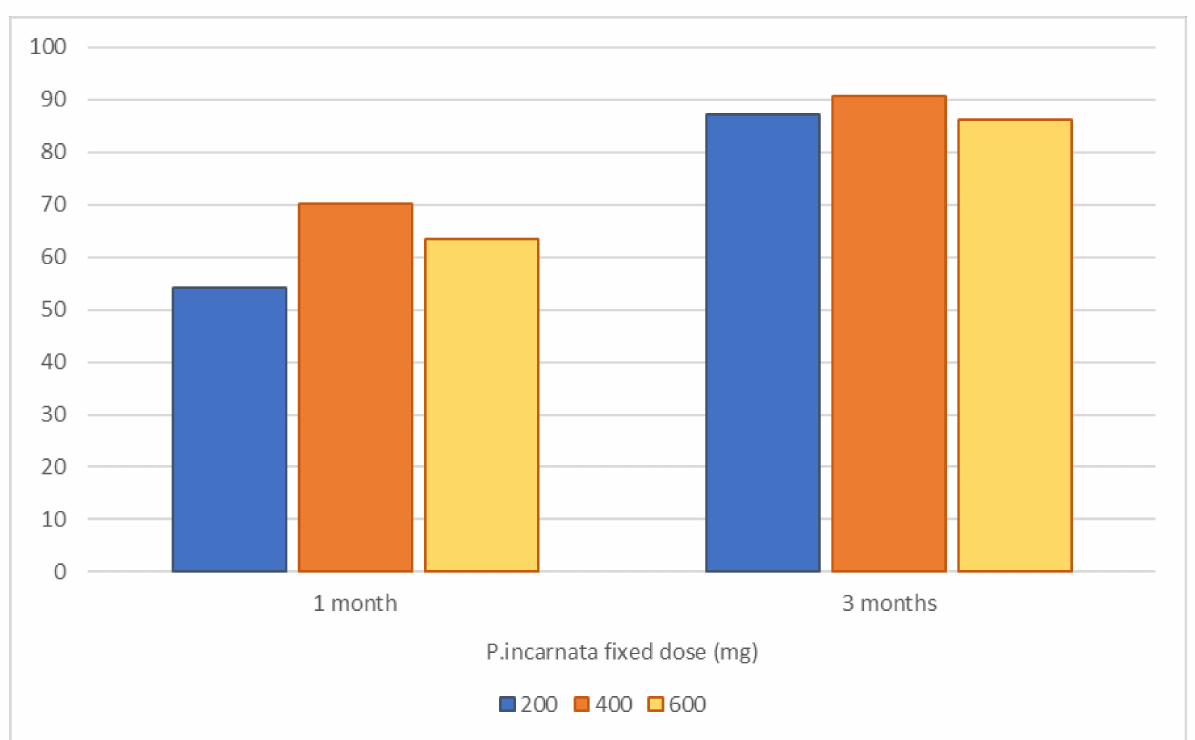
Figure 2. Percent BDZ reduction after 1 month or 3 months from the beginning of the tapering program in patients treated with a dry extract of P. Incarnata L., herba